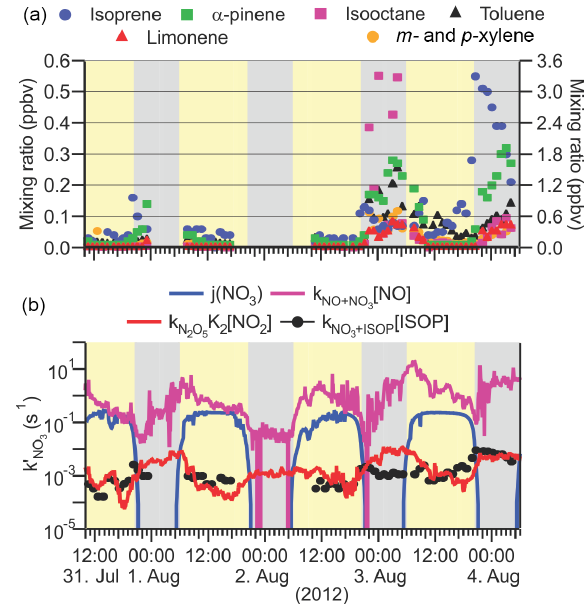
Figure 7. (a) Time series of selected VOC mixing ratios observed on the nights of 2/3 and 3/4 August, 2012. Biogenic VOCs (iso- prene, α -pinene and limonene) are shown on the left-hand axis, and anthropogenic VOCs (isooctane, toluene and m - and p -xylene) on the right-hand axis. The α -pinene and limonene measurements are semi-quantitative. (b) Time series of NO 3 loss-rate coefficients. ISOP =